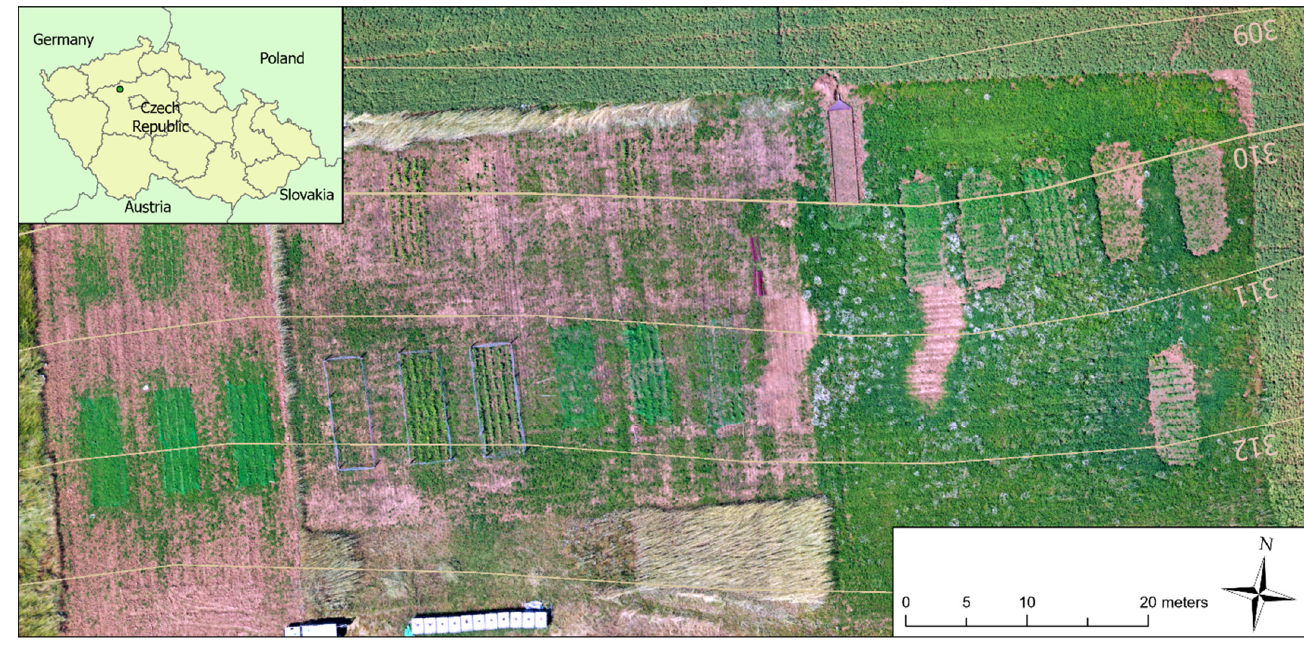
Figure 1. Map of the experimental area, experimental plots visible (rectangles). The experimental plots were established using standard tillage typical for the